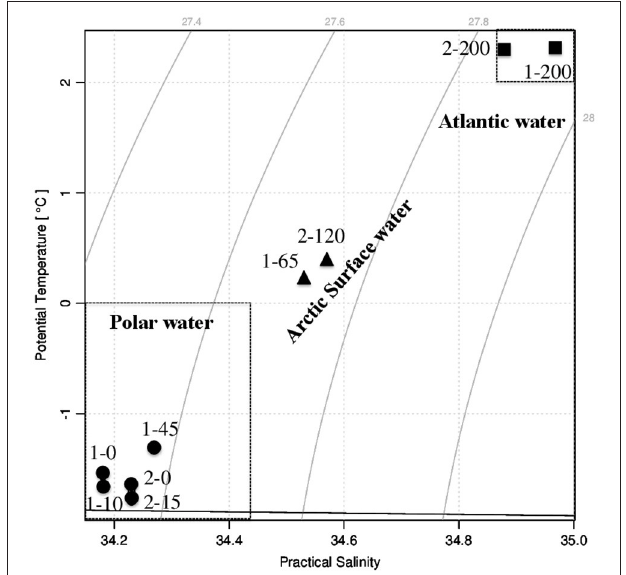
FIGURE 2 | Temperature-salinity diagram showing the water masses present at sampling Stations 1 and 2. The names of the collected water samples were according to their station number and depth. Circles represent Polar Water (PW) samples, triangles represent Arctic Surface Water (ASW) samples, and squares represent Atlantic Water (AW)